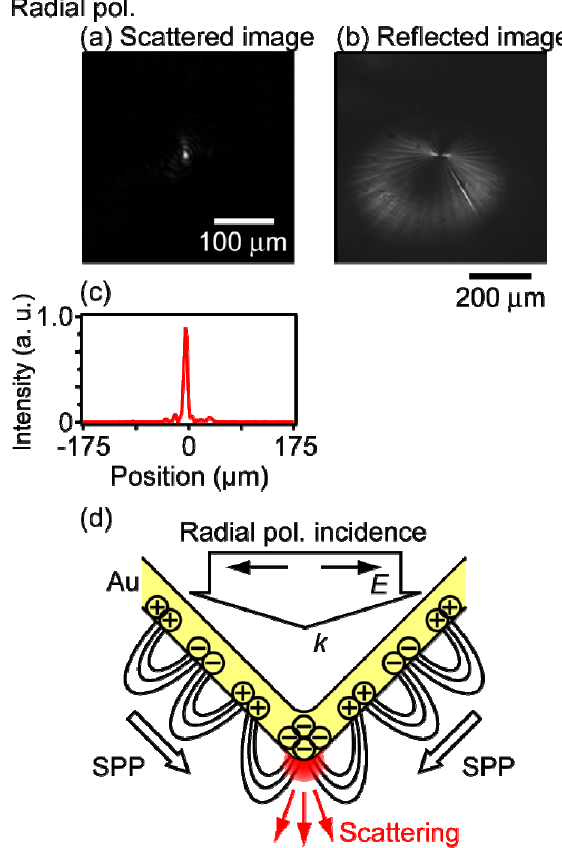
Figure 2. Observed ( a ) scattering and ( b ) reflection images for radial polarization incidence. Scattering is observed only from the apex. The reflection intensity is fairly dark due to the surface plasmon excitation; ( c ) Line profile of the intensity at the center of the scattering image; ( d ) The mechanism of the scattering from the apex is schematically explained. Constructive interference of surface plasmons occurs at the